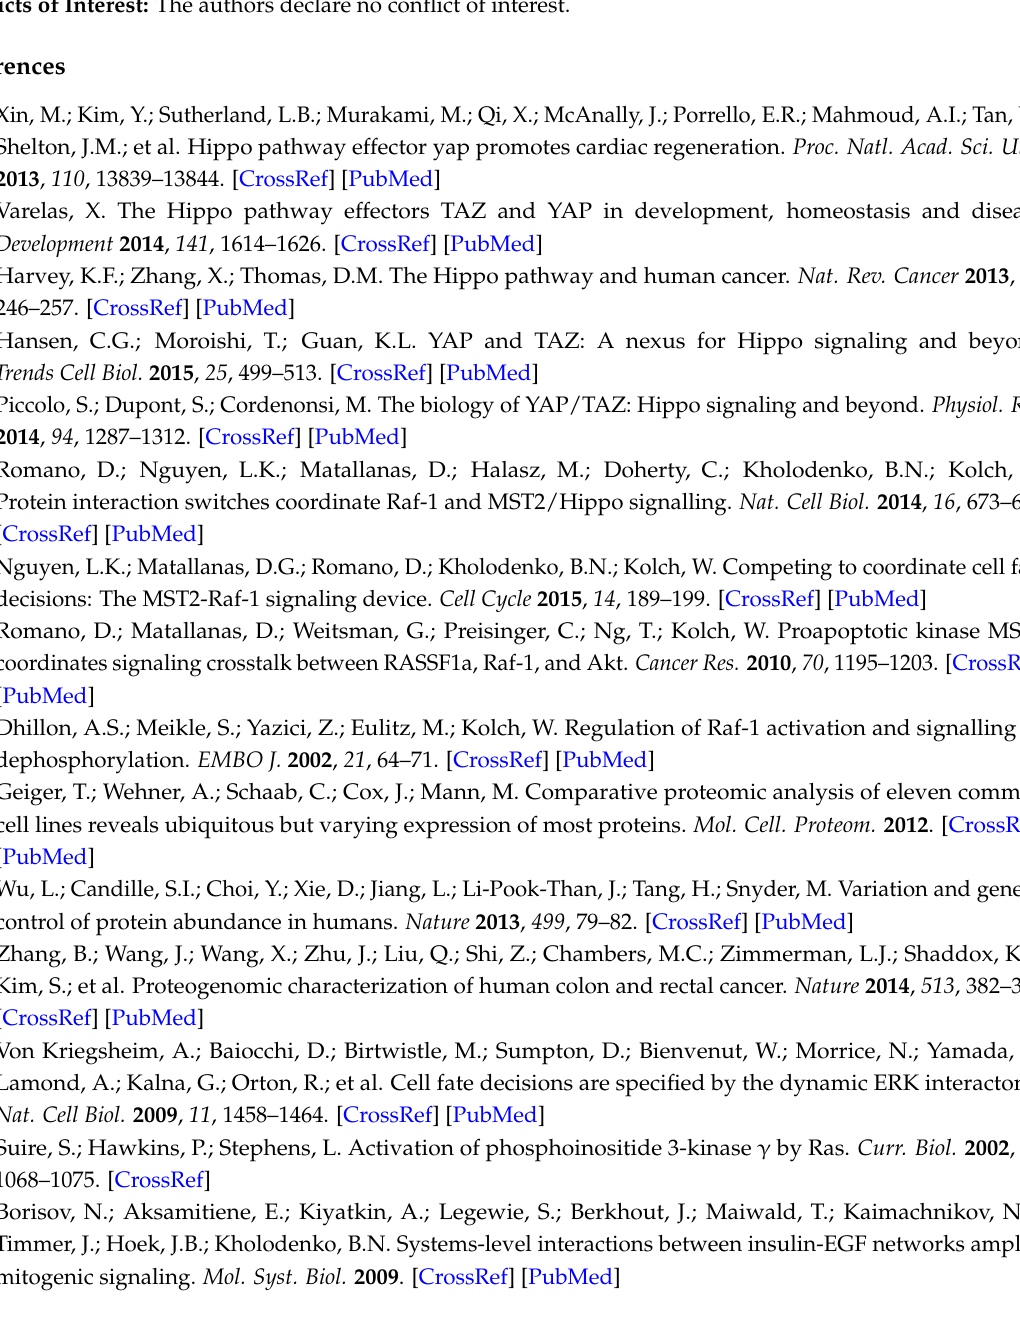
Figure S1: Various response patterns generated by increasing Akt, Figure S2: Various response patterns generated by increasing Ras, Table S1: Reactions and reaction rates of the Hippo-ERK network model, Table S2: Ordinary differential equations of the Hippo-ERK network model, Table S3: Parameter values used in the model, Table S4: Parameter values clustered for the response pattern